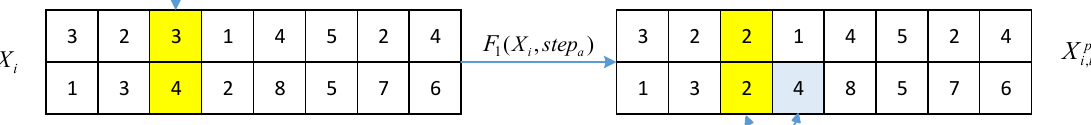
Figure 2. Operation in walking behavior. F 1 ( X i , step a ) randomly selects step a columns in X i , the values of the first row in these columns are randomly selected from [ 1, N V ] , while the values of the second row are randomly